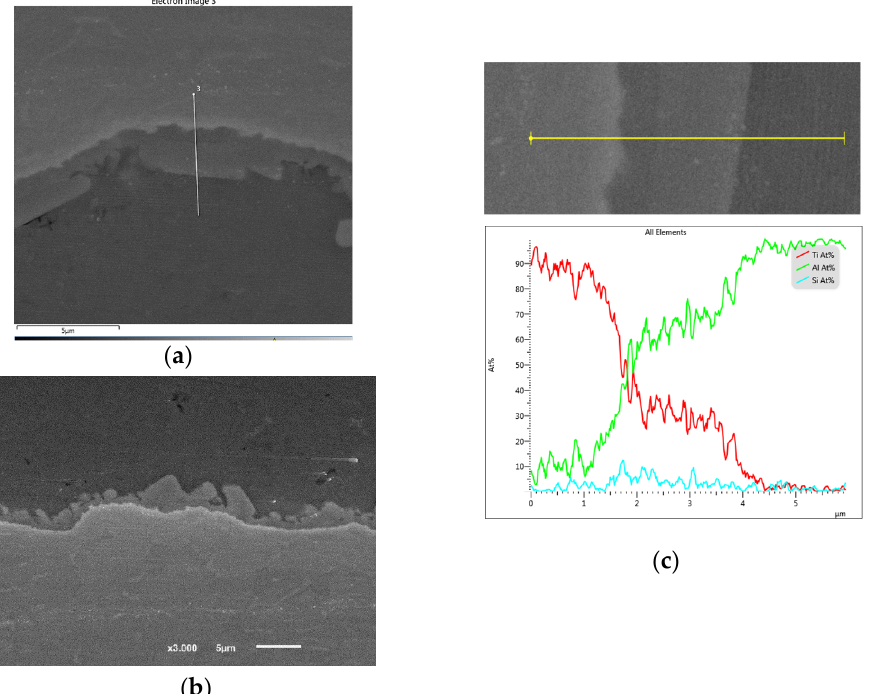
Figure 18. SEM images (SEI) of 1/680 joint interfaces at: ( a ) The active part of the parent metal; ( b ) The passive part; ( c ) EDS line position and analysis of the interface in ( a ). The brazing using the Al-13Si filler at a lower temperature (585 ◦ C), resulted in an intermetallic thickness of about 1.85 ± 0.1 µ m (Figures 19 and 24), which is comparable with the Al-1Si layer thickness at 680 ◦ C, except that the intermetallic layer in Ti/Al-13Si/Ti has a relatively consistent thickness and is composed of Ti 7 Al 5 Si 12 .